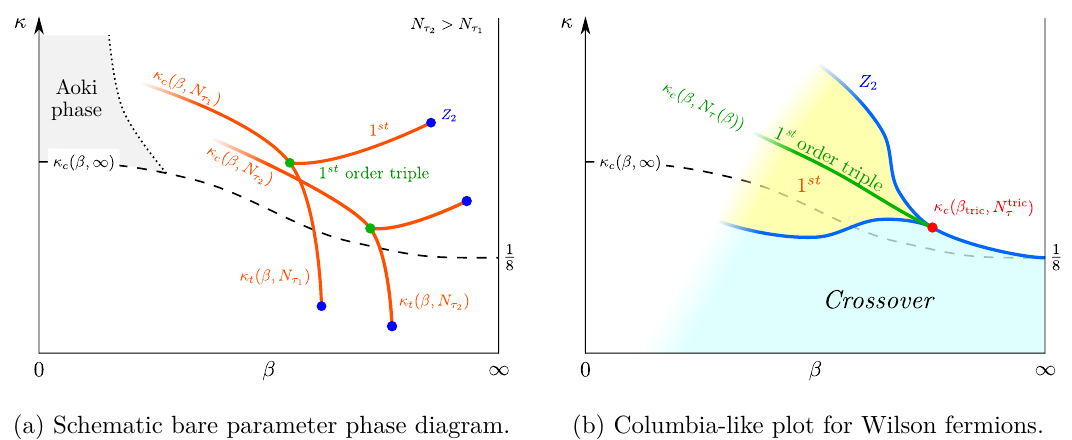
Figure 11. Suggested phase structure of finite temperature lattice QCD with Wilson fermions. In (b) N τ is implicitly tuned so that each point ( κ, β ( N τ )) is on the phase boundary. The line κ c ( β, N τ ( β )) denotes the chiral limit at finite temperature and is a triple line, which ends in a tricritical